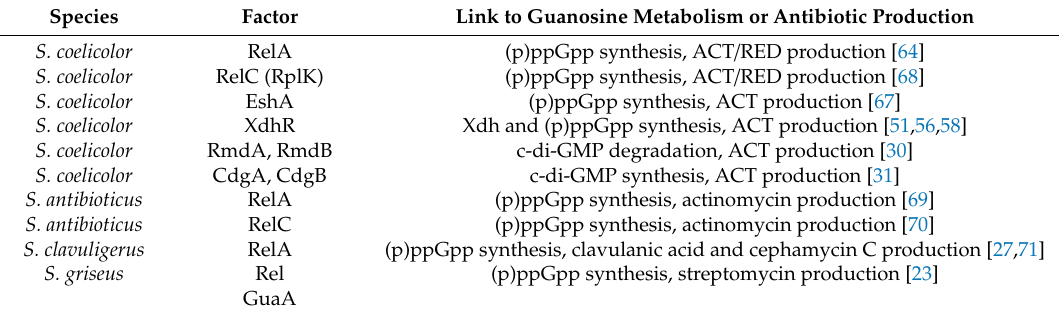
Table 1. Examples of factors involved in antibiotic production in Streptomyces spp. that are linked to stress response or GTP